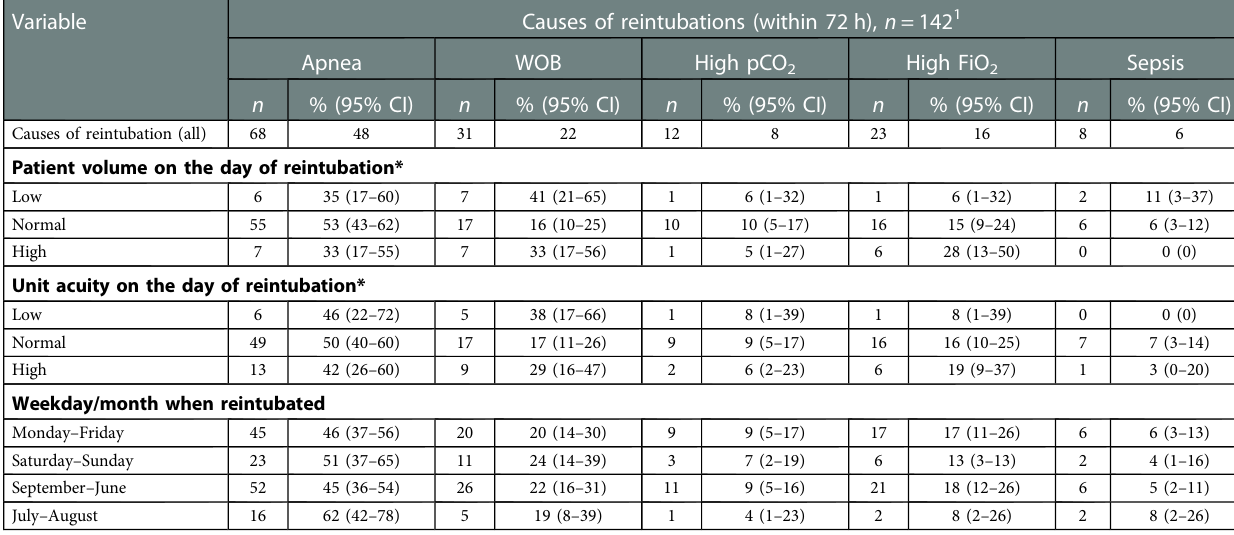
TABLE 3 Causes of reintubation and associations with patient volume, unit acuity, and the weekday the infant was reintubated.